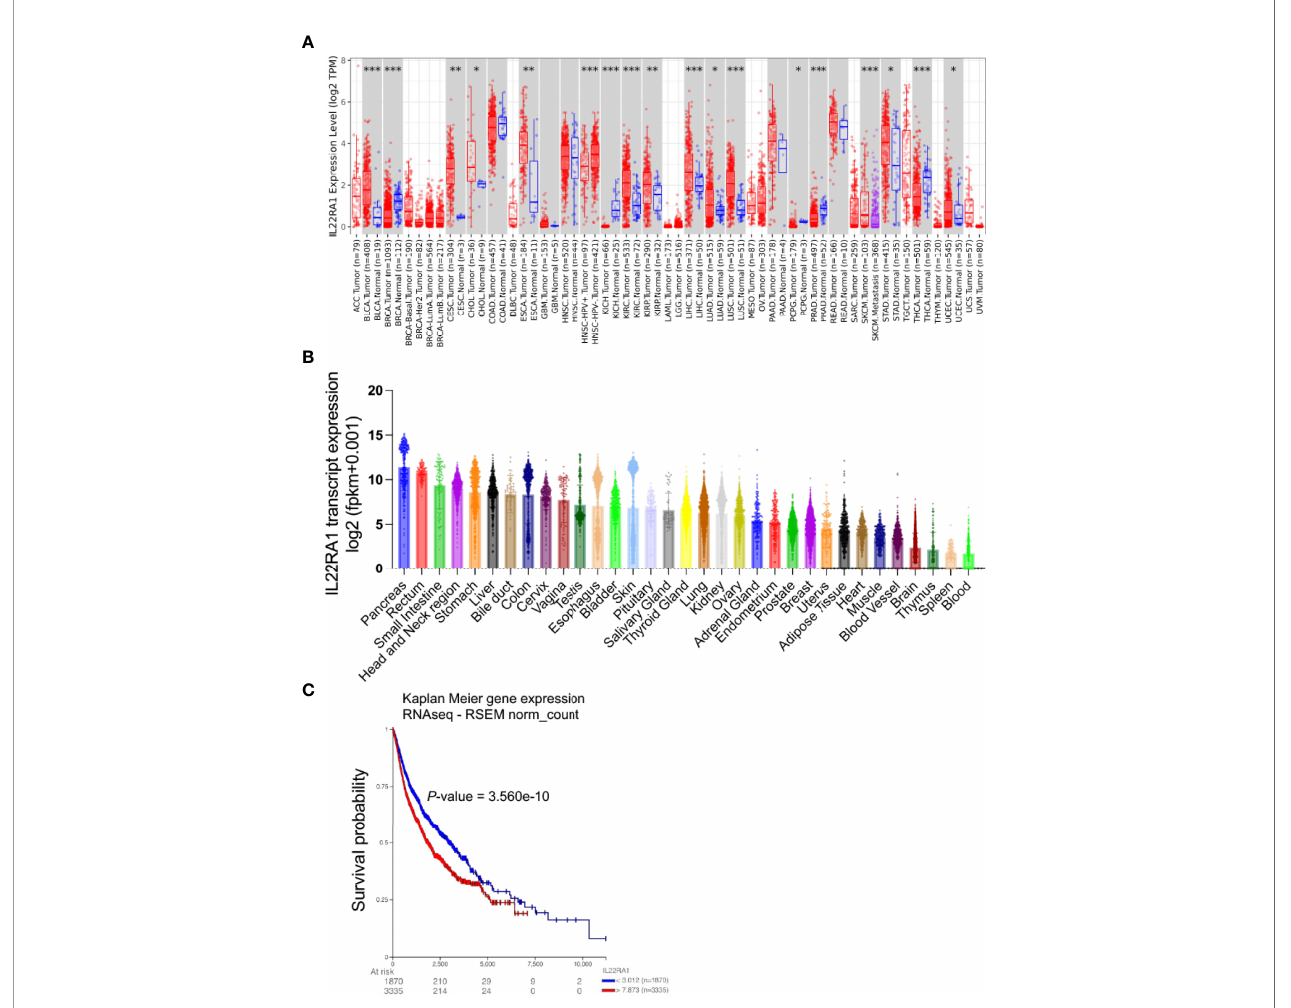
FIGURE 1 | Expression of IL22RA1 is upregulated in tumors compared with normal tissues among 11 cancers and high expression worsens survival in patients. Data were obtained from TIMER2.0 (http://timer.cistrome.org) and TCGA/TARGET/GTEx databases. (A) Overexpression of IL22RA1 transcript in multiple tumors. * p < 0.05, ** p < 0.01, *** p < 0.001. (B) The transcriptive level of IL22RA1 in different organs among diverse cancer types. (C) Kaplan Meier Plot shows the effect of higher IL22RA1 expression on overall survival in